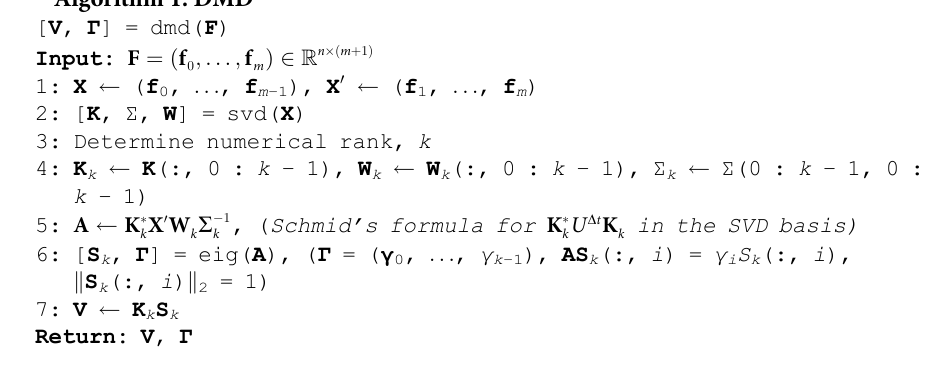
algorithm first looks for a matrix A : R n ! R n that approximates U Δ t on the Krylov subspace ; . . . ; f g � F . That is, we are looking for a matrix representation A of K ¼ span f f 0 m (cid:0) 1 : F ! K is the orthogonal projection of functions onto K . P U D t : K ! K , where P K K